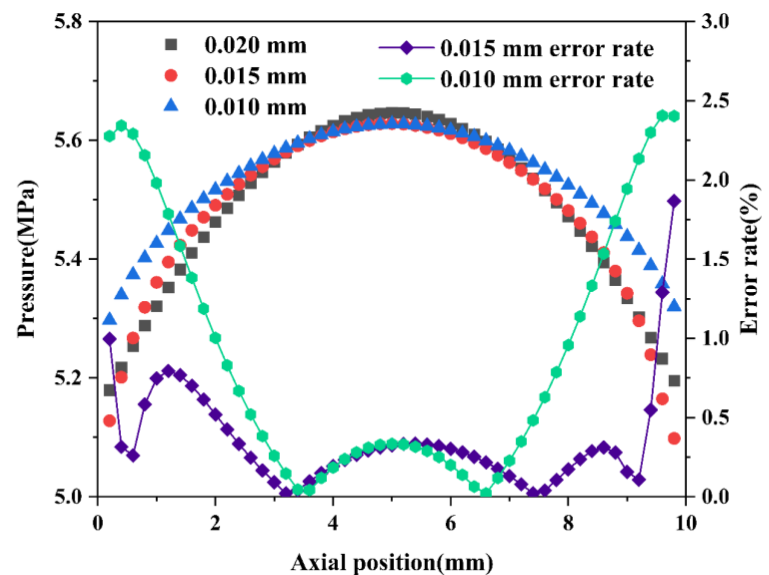
Figure 8. Mesh convergence analysis experimental results.